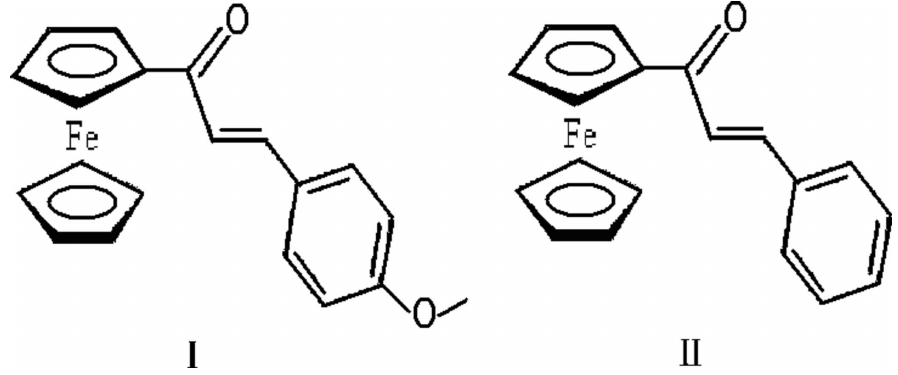
Figure 4 Schematic representations of the structures of (I) and (II). ( E